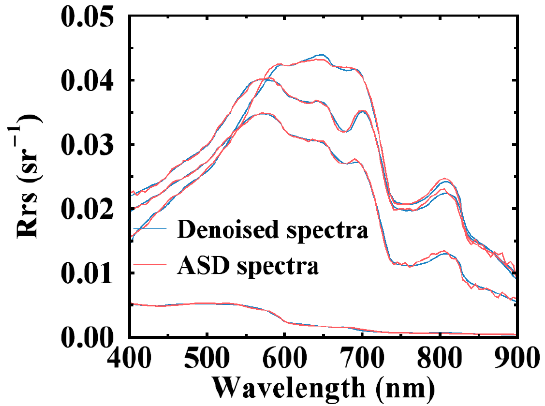
Figure 7. Typical ASD measured and their denoised spectra.